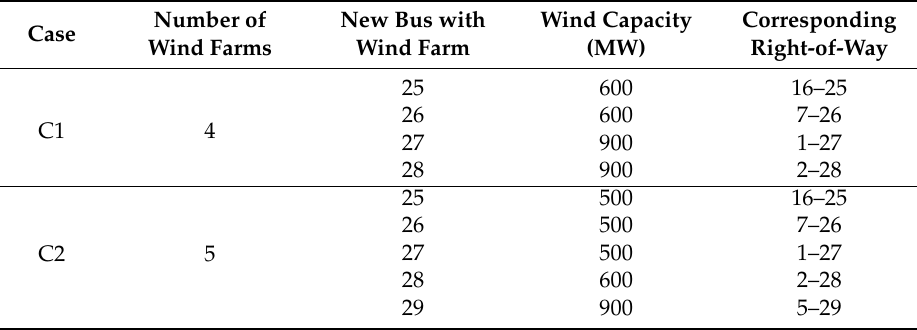
Table 4. Case information for the integrated wind farms.